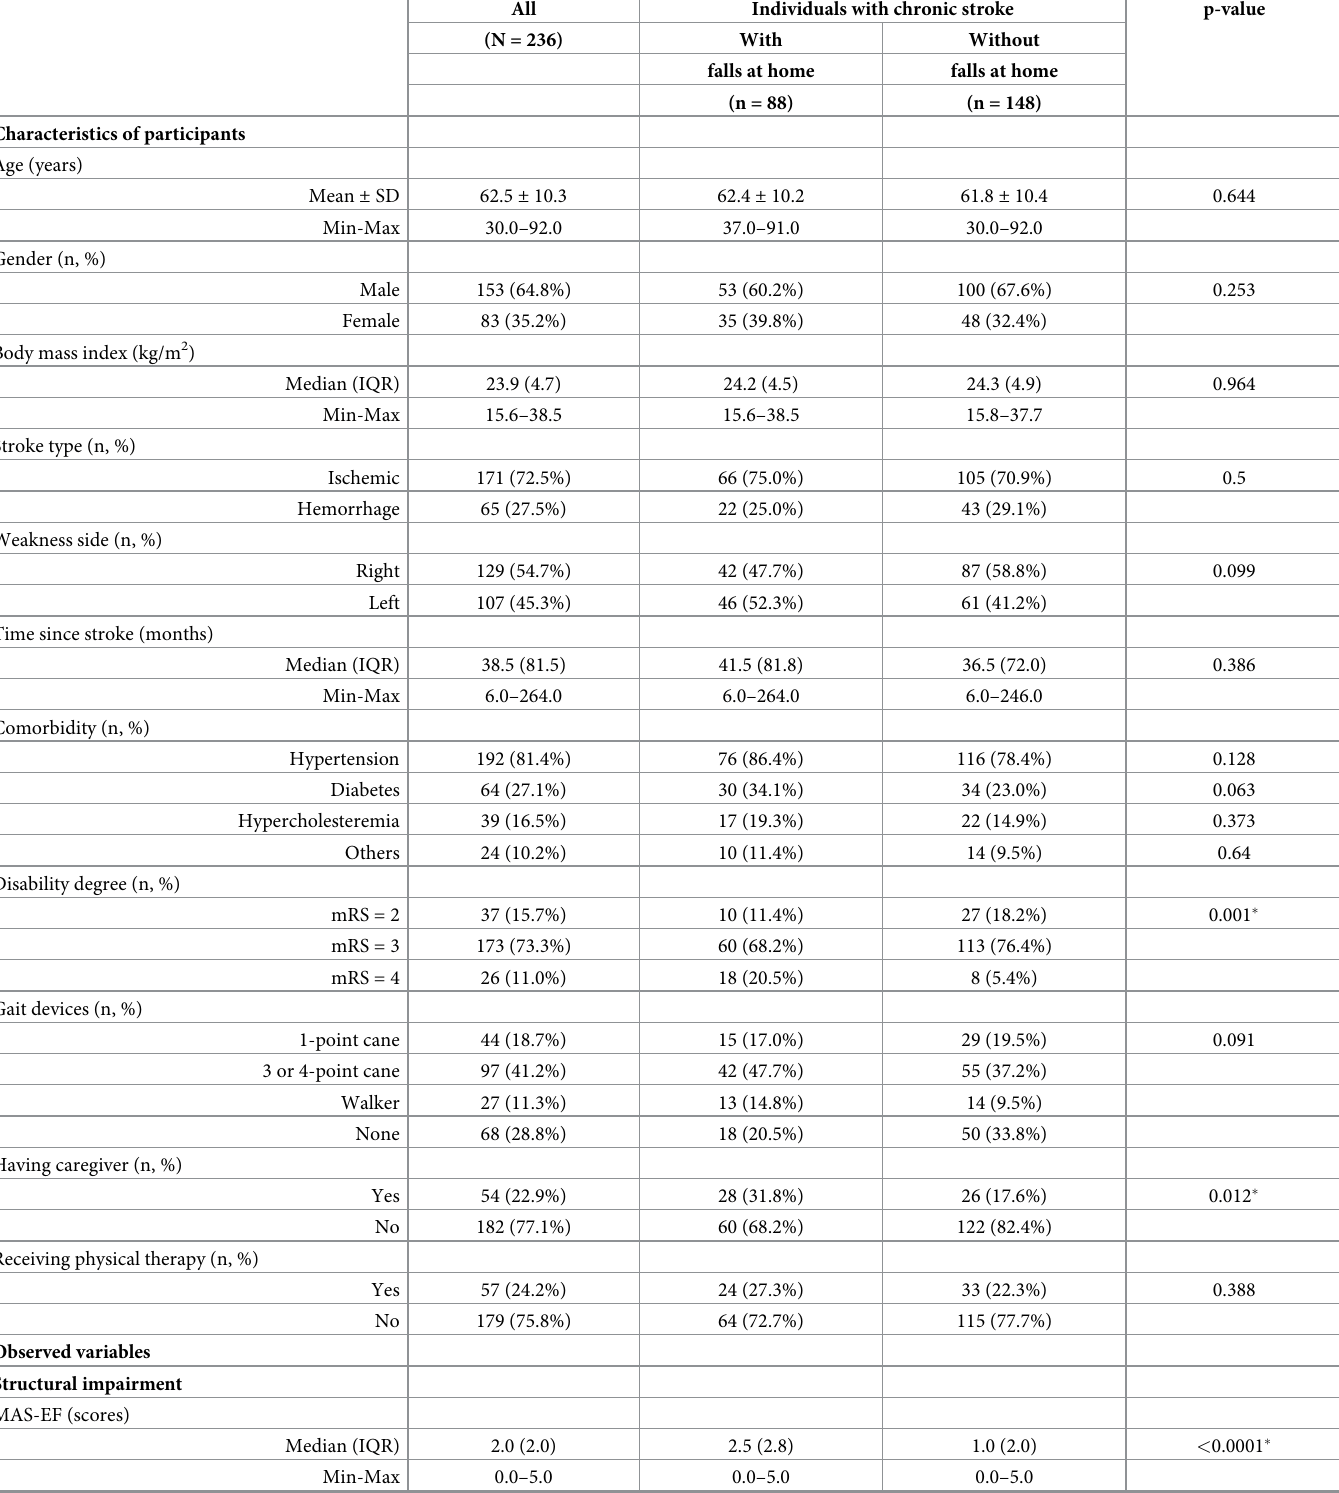
Table 1. Characteristics of participants and results of observed variables. All Individuals with chronic stroke p-value (N = 236) With Without falls at home falls at home (n = 88) (n =